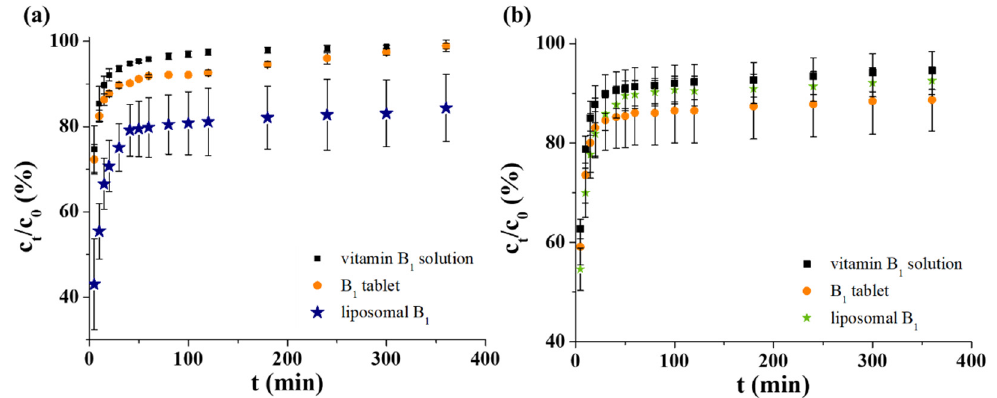
Figure 4. The dissolution profiles of vitamin B 1 in ( a ) PBS and ( b ) artificial gastric juice. To mimic the gastric condition, an artificial gastric juice was applied, which contains 0.2 M KCl at pH = 1.5. The presence of pepsin was omitted for easier spectrophotometric measurement of samples. For better comparison as well as to avoid the high pH gradient (from pH = 7.4 to pH = 1.5), the manufactured tablets were dissolved in acidic 0.2 M KCl (pH = 3.0) solution. As can be seen in Figure 4b, ~92% of the control non-formulated vita-